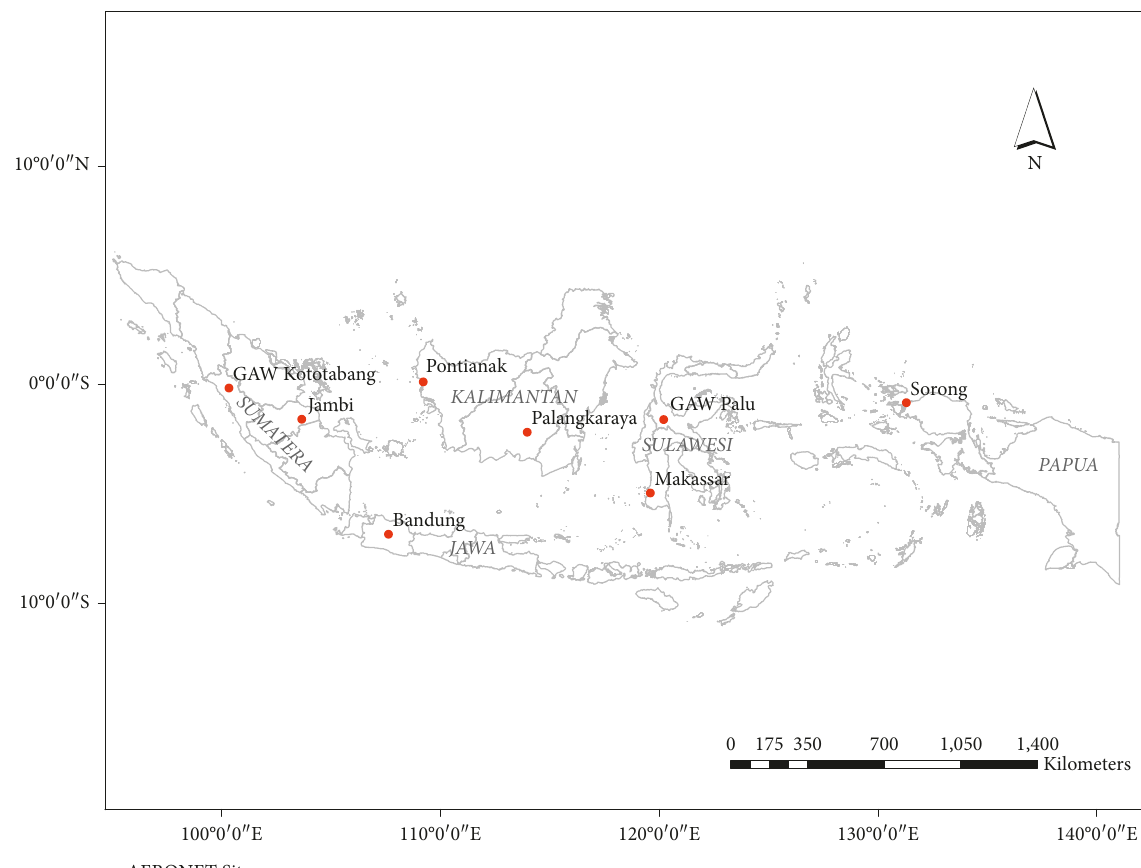
Figure 1: Aerosol robotic network (AERONET) sites used in this